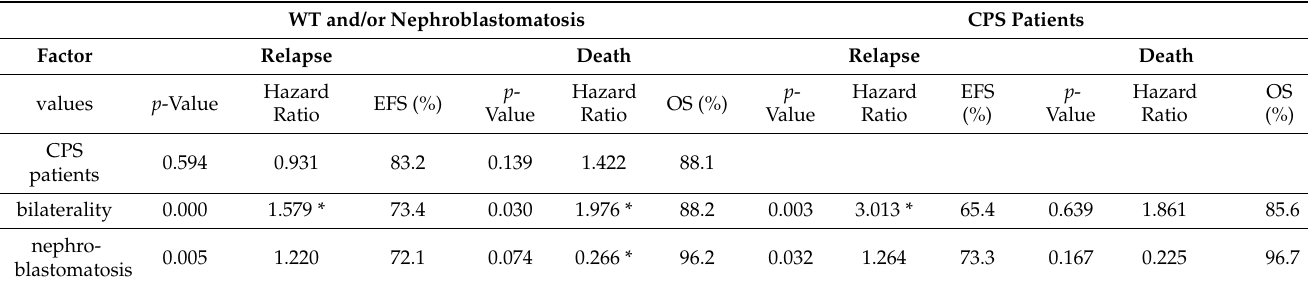
Table 5. Multivariate analysis in patients with a WT and/or nephroblastomatosis and only in patients with a syndrome; *: p < 0.05. CPS: cancer predisposition syndrome.